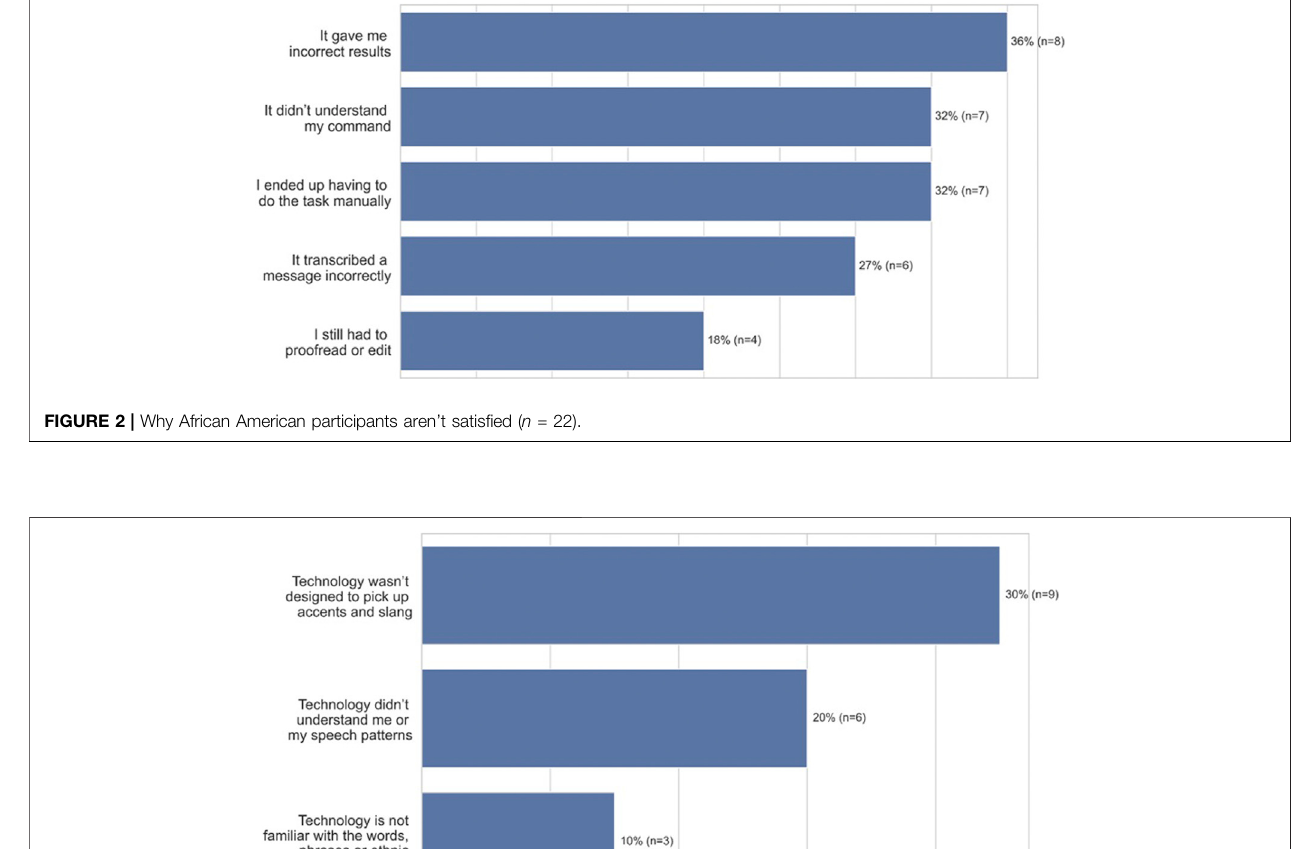
Frontiers in Arti fi cial Intelligence |